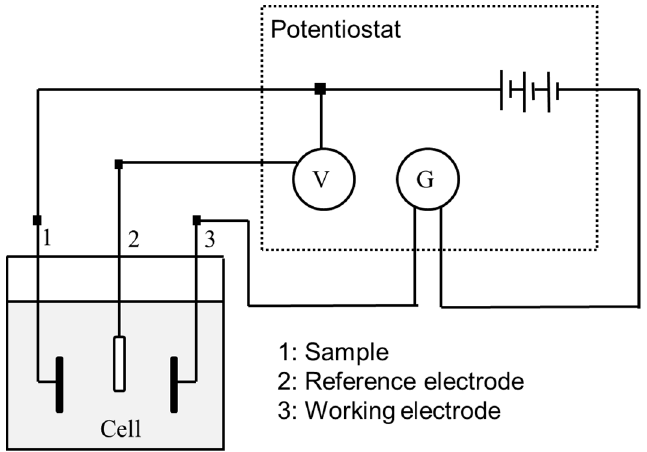
Figure 1. Three-electrode electrical circuit set-up diagram used in electrochemical tests.